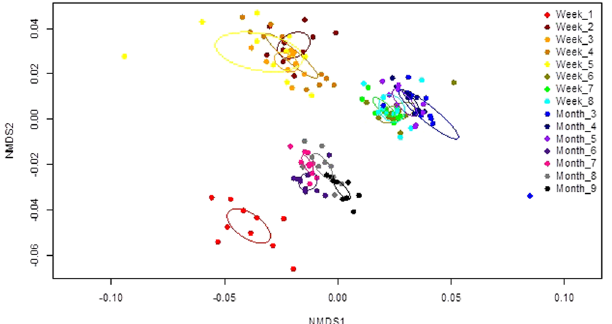
Figure 5. Calliphora vicina hydrocarbon profiles of puparial cases aged from 1 week to 9 months were visualized using a non-metric multidimensional scaling ordination based on a Bray-Curtis dissimilarity matrix and plotted on two dimensions (stress = 0.138, R 2 = 0.967); each puparial case age had a 95% confidence ellipses around class